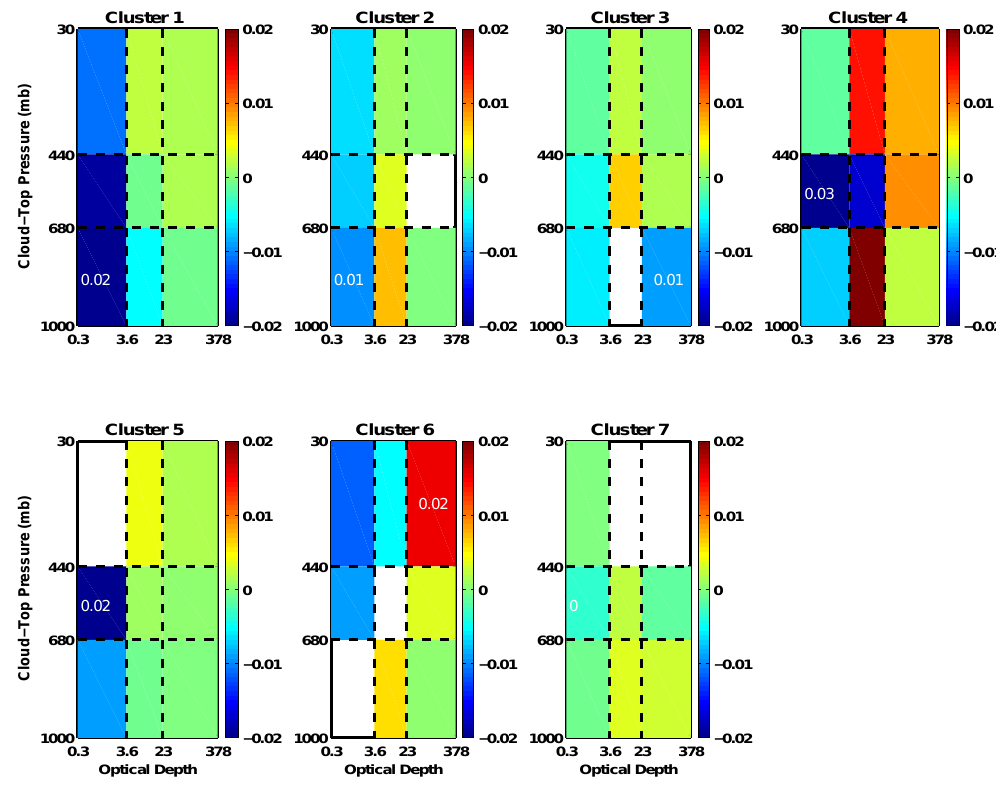
Fig. 13. ISCCP histograms of difference in cloud fraction between warm and cold subsets for each cluster.